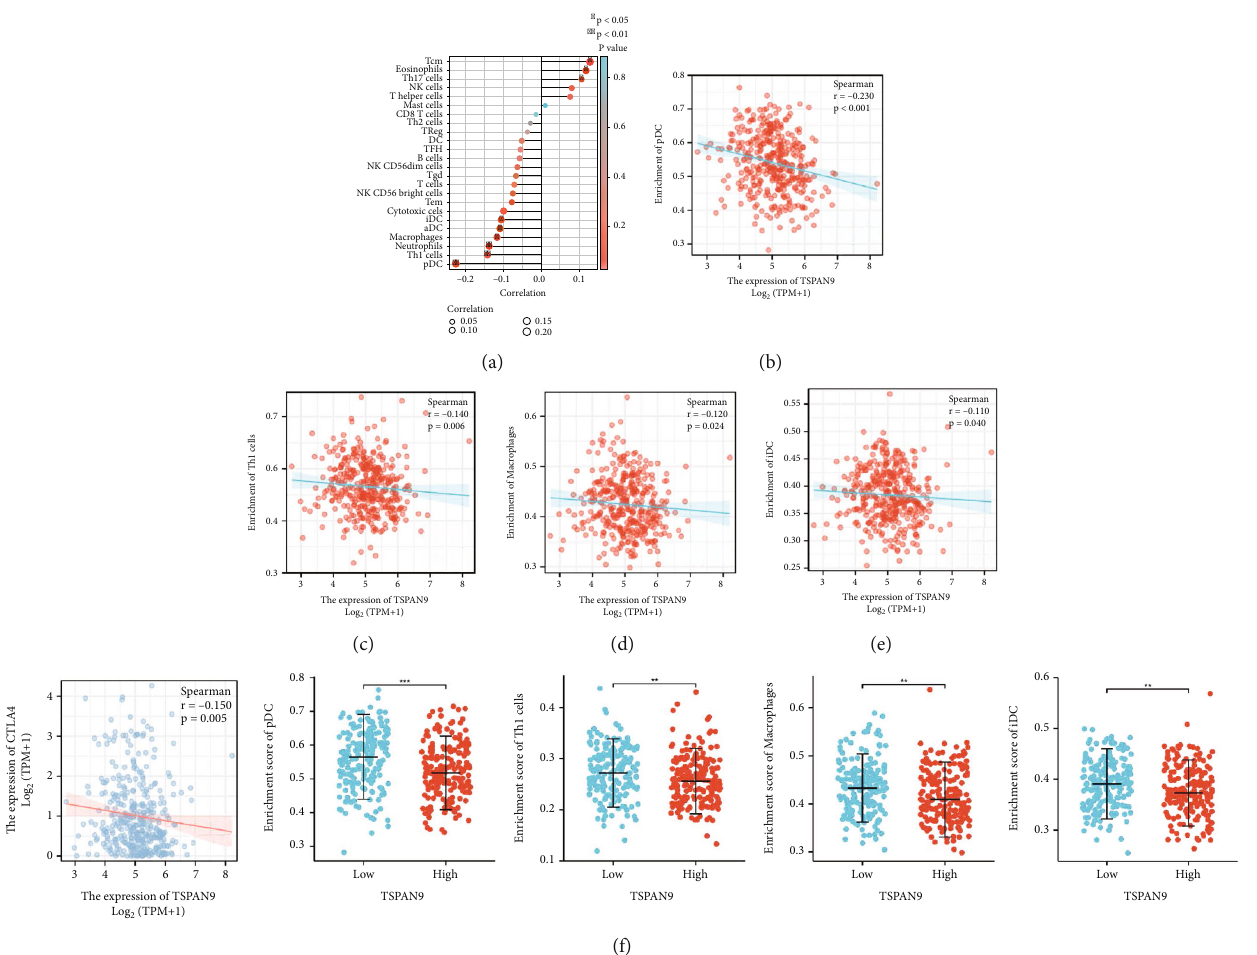
Figure 3: The TSPAN9 correlation analysis on the indexes of immune cell in fi ltration and immune checkpoint. (a) A lollipop diagram on the correlation and the correlation degree of TSPAN9 and the multiple immune cell in fi ltration in HCC. (b – e) The correlation of TSPAN9 with pDC (b), Th1 cell (c), macrophage (d), and iDC (e) in fi ltration level. (f) The expression correlation of TSPAN9 and